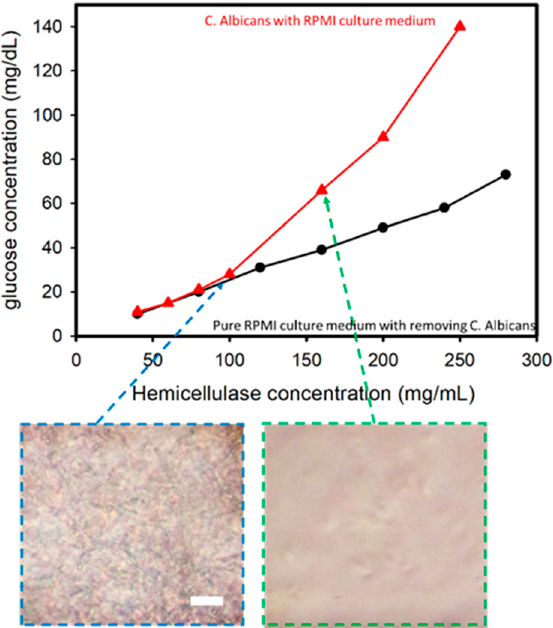
Figure 3. Glucose concentration versus hemicellulaose concentration for Candida albicans in a RPMI culture medium. The inserted images show that when concentration of hemicellulase is higher than 150 mg/mL, C. albicans can be lysed in 1 min (incubation time of 1min). Scale bar: 50 μ m.